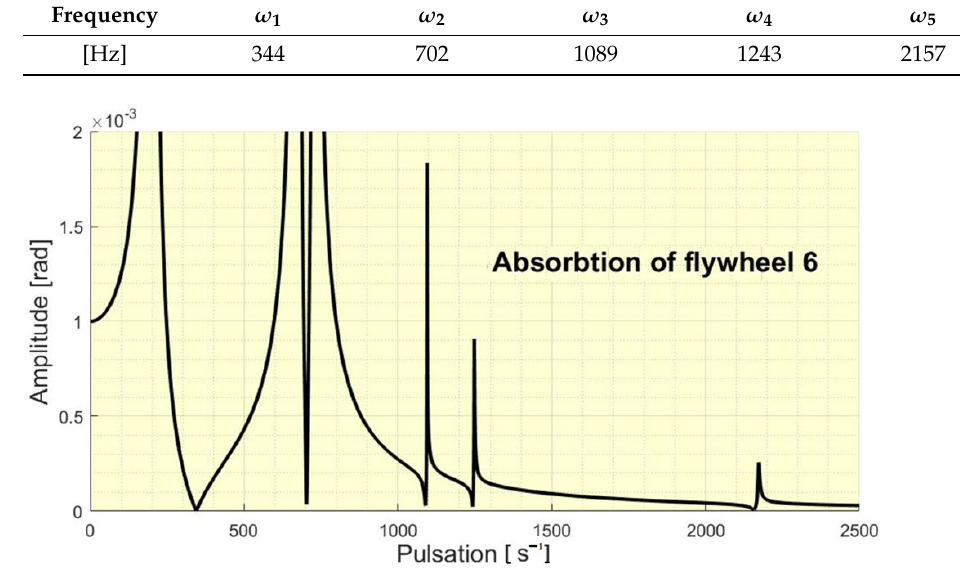
Figure 3. The absorbtion of the flywheel 6.